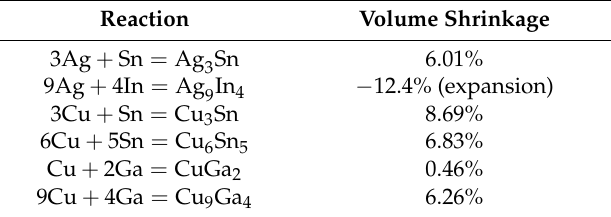
Table 4. Volume changes associated with interfacial reactions in soldering process